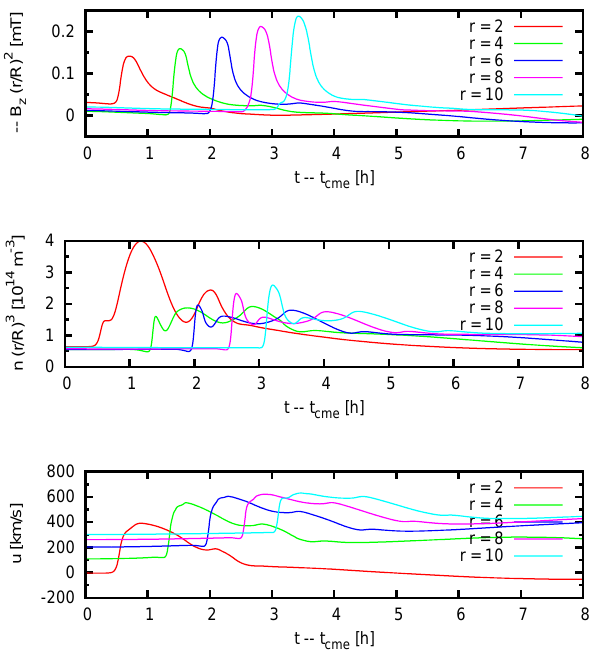
Fig. 10. Simulated profiles of magnetic field, density, and fluid ve- locity as seen by static observers situated along the CME expansion direction at radii r/R (cid:12) ∈{ 2 , 4 , 6 , 8 , 10 } for the sequence of Fig. 6. The minus sign at B z compensates for the magnetic field’s north- south polarity (which has B z < 0 at z = 0). Time is given in hours after CME onset. Temperature profiles are not shown due to γ = 1.